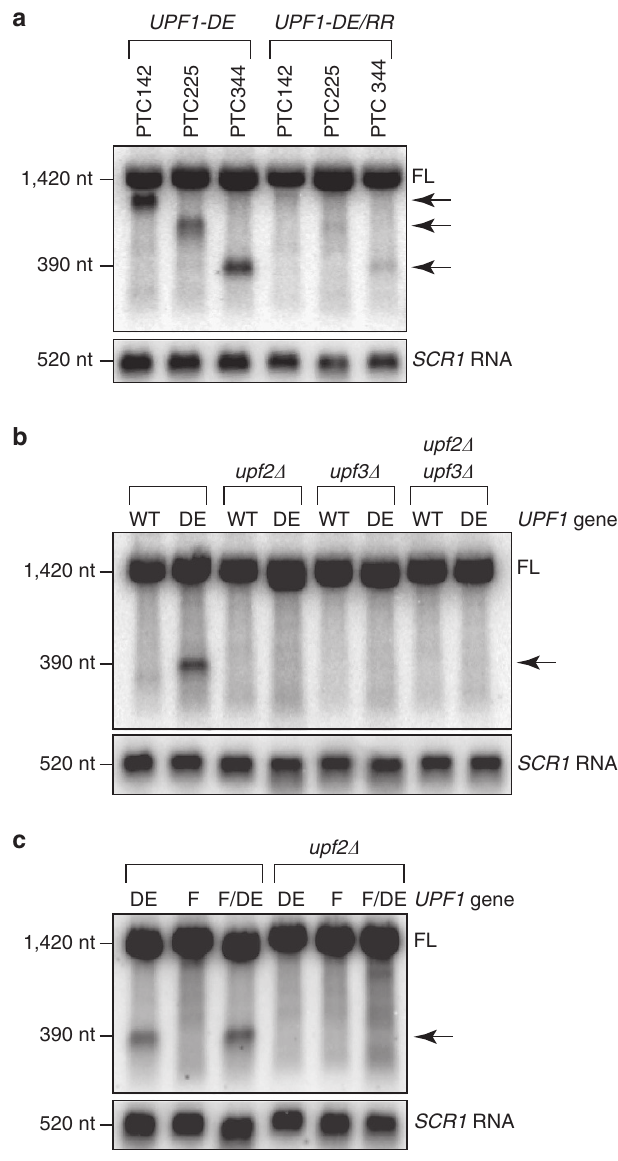
Figure 4 | UPF1 function in premature translation termination requires RNA binding and cofactors UPF2 and UPF3. ( a – c ) Northern blot analysis of PTC-containing PGK1 reporter mRNA. ( a ) upf1 D cells complemented with either ATPase-deficient UPF1 ( UPF1-DE ) or the same mutant also lacking RNA-binding activity ( UPF1-DE/RR ). ( b ) PGK1-PTC344 reporter mRNA in upf1 D cells expressing wild-type (WT) or mutant UPF1 (DE) and also lacking UPF2 ( upf2 D ), UPF3 ( upf3 D ) or both ( upf2 D upf3 D ). ( c ) PGK1- PTC344 reporter mRNA in upf1 D cells expressing ATPase-deficient UPF1 (DE), mutant UPF1 relieved for allosteric inhibition of ATPase and helicase activities (F), or UPF1 harbouring both mutations (F/DE) in cells either with or without UPF2 ( upf2 D ). Full-length reporter mRNA (FL) and 3 0 RNA fragments (arrow) are indicated. RNA levels were normalized to NMD- insensitive SCR1 RNA. Results are representative of three independent experiments. Nt, nucleotide.